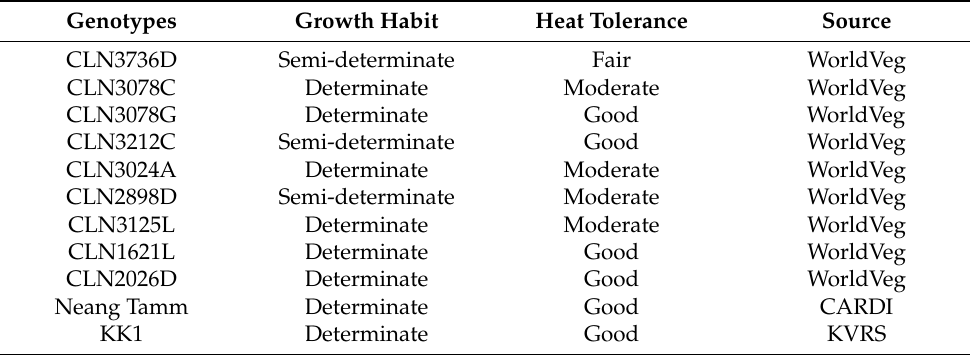
Table 6. Pedigree information of genotypes used in this